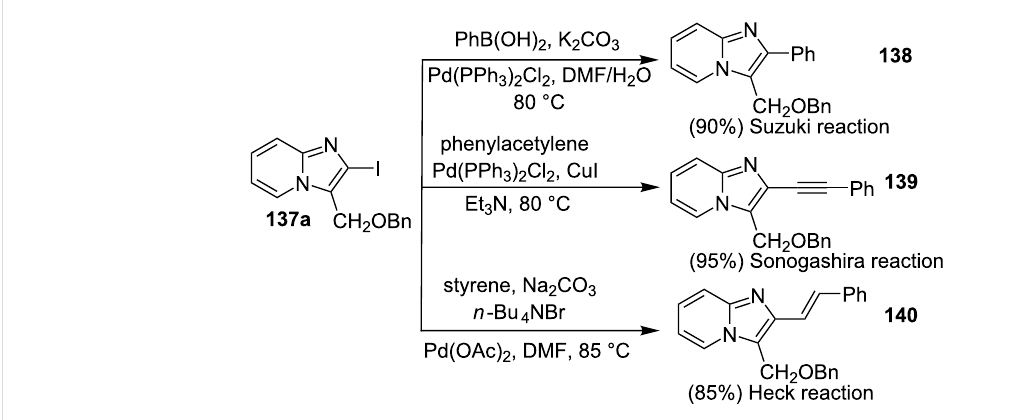
Scheme 48: Application towards different coupling reactions.